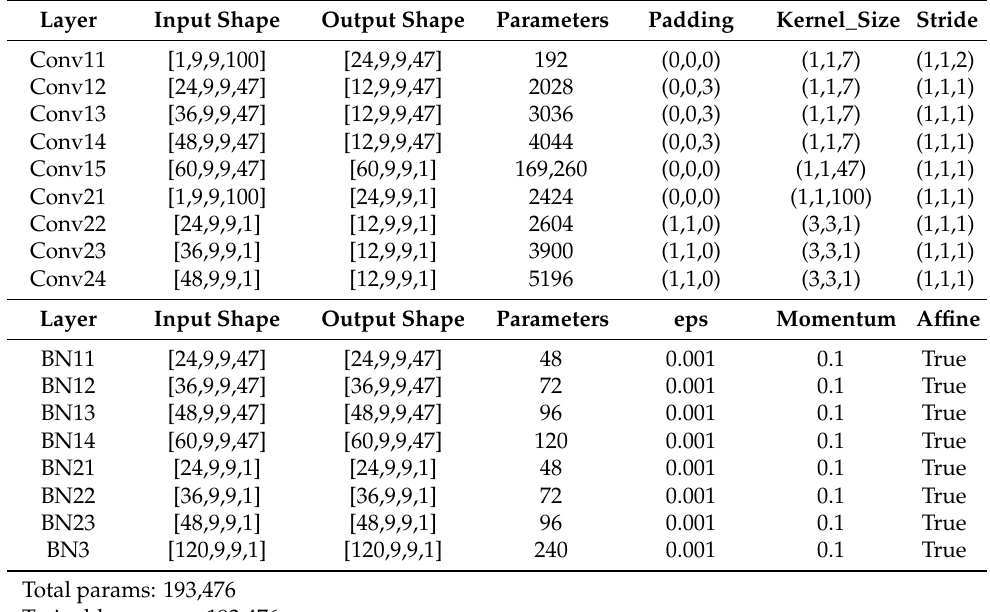
Table 1. Parameters of the 3D convolutions and batchnorms in our